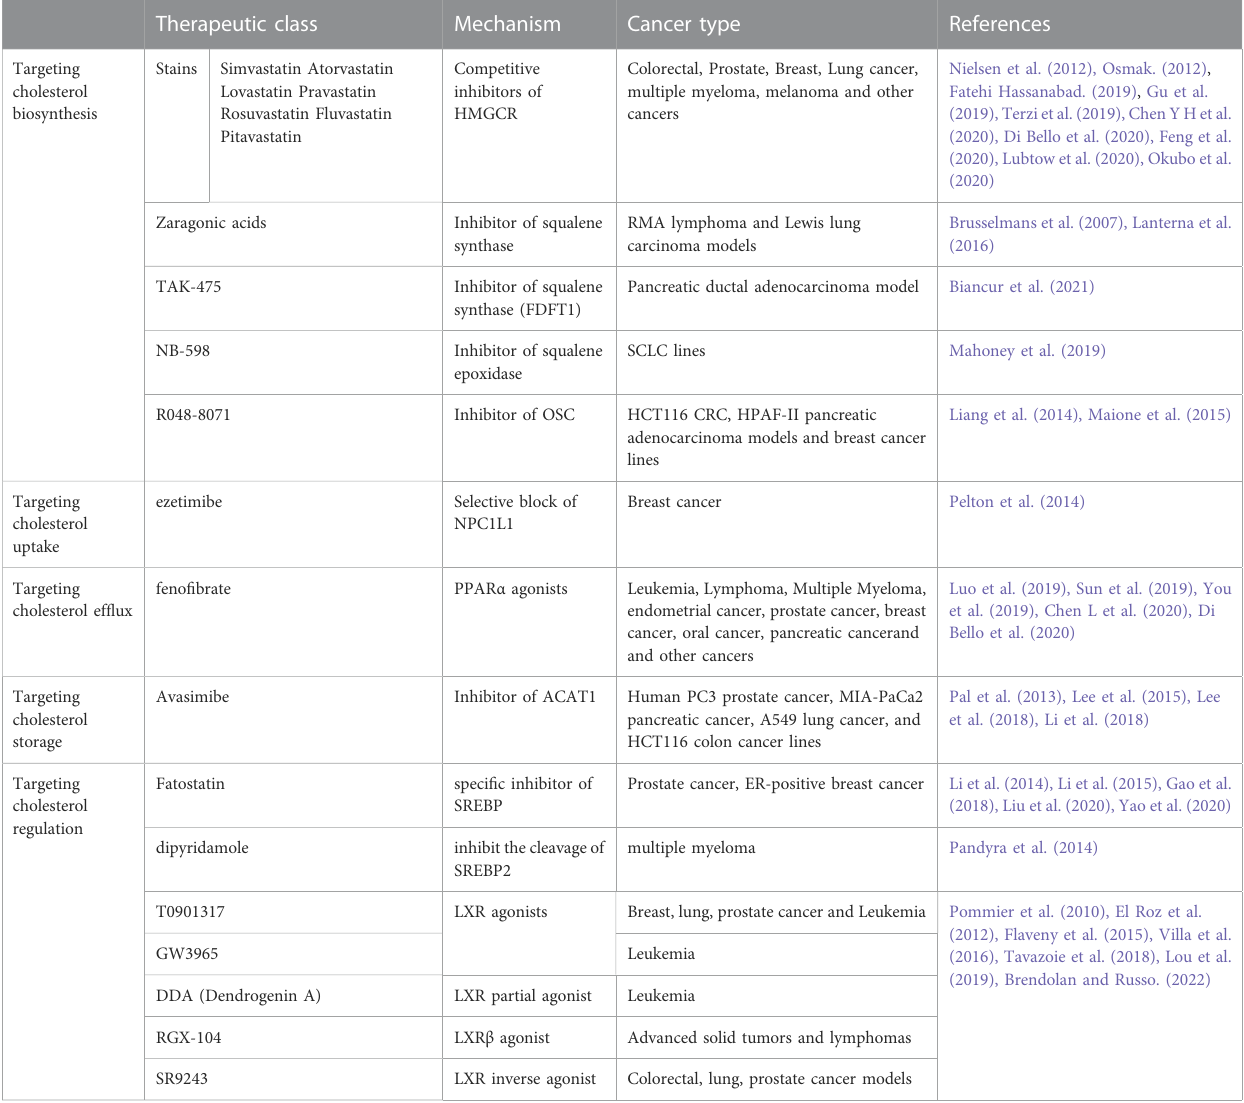
TABLE 1 Anti-cancer therapies that target cholesterol